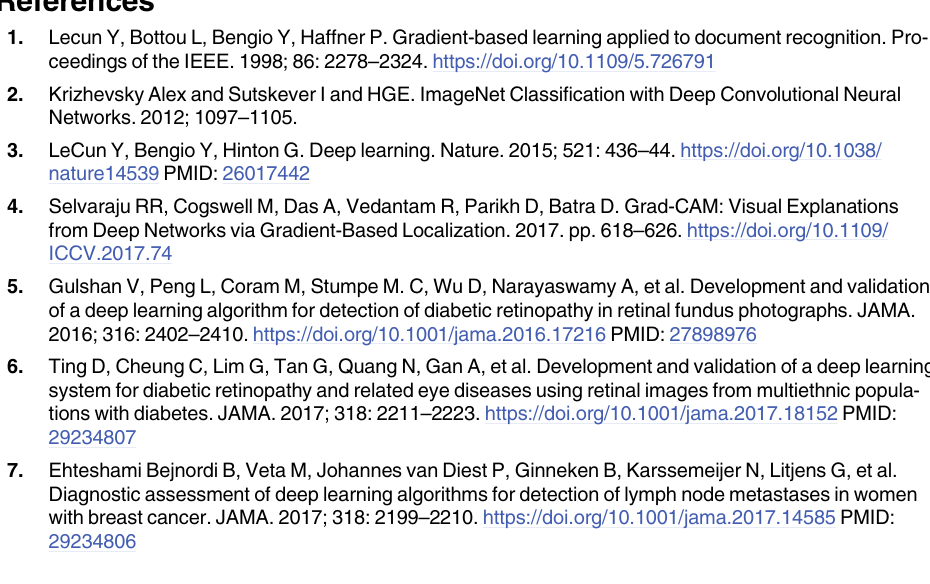
S4 Table. Performance with patient location. CNN-RL AUC comparison between